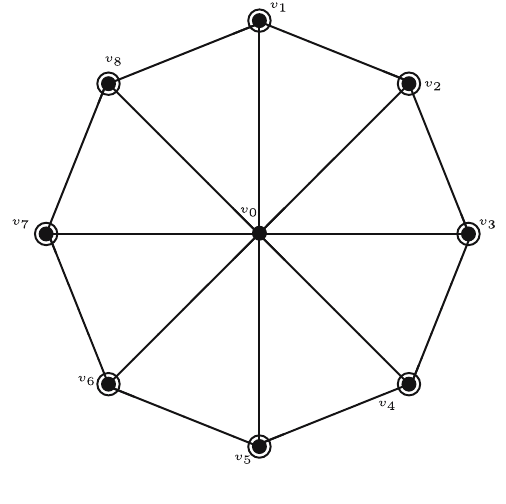
Figure 2: Graph W 8 .